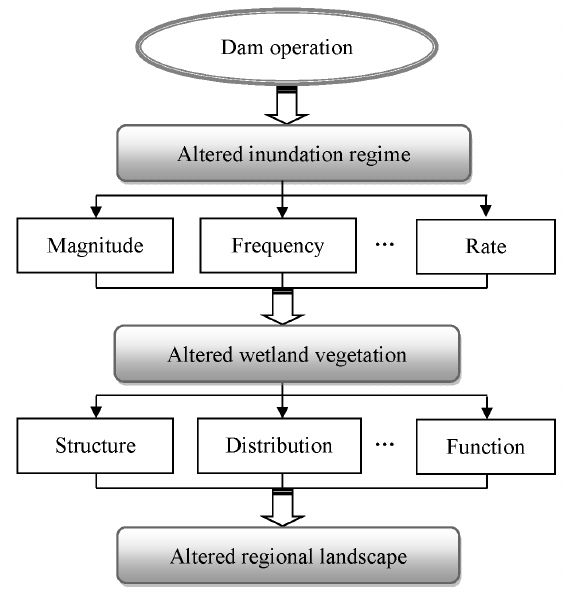
Figure 1. A flow chart of a wetland’s hydro-ecological processes that respond to dam operation.